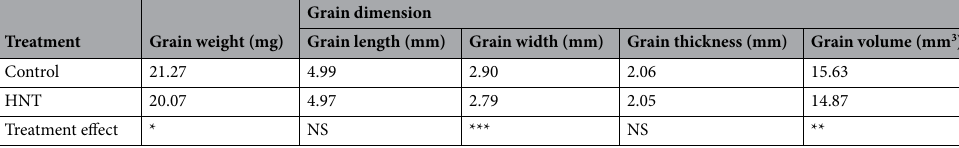
Table1. Grain weight and dimension (grain length, width, thickness, and volume) in control and HNT treatment at maturation. Data of grain weight are the mean ± SE of 5–6 individual plants, 8 grains per plant. *, ** and *** shows p < 0.05, 0.01 and 0.001 by Student’s t -test, respectively. NS, no significant difference (Student’s t -test, p > 0.05). For the determination of grain dimension, see “Materials and Methods”